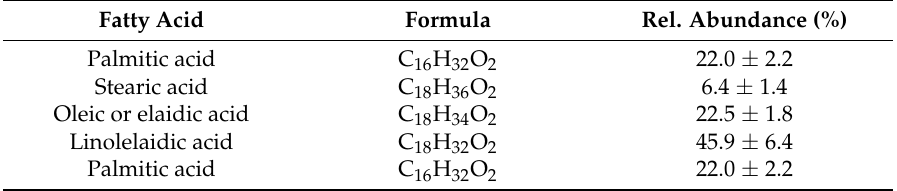
Table 1. Fatty acid composition of the biosurfactant extracted from corn steep liquor (CSL) [31]. Fatty Acid